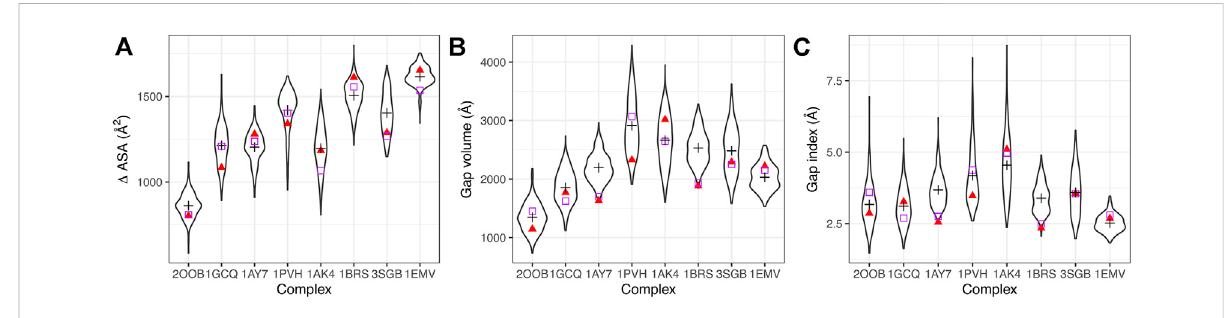
Geometricinterface parameters. (A) Interface size measured by Δ ASA, (B) gap volume, (C) gapindex.Distributions of values sampled during the simulations are represented in black as violin plots, with the average value indicated by a black cross. Red triangles indicate the initial values (t = 0), purple squares the values in the X-ray structures.